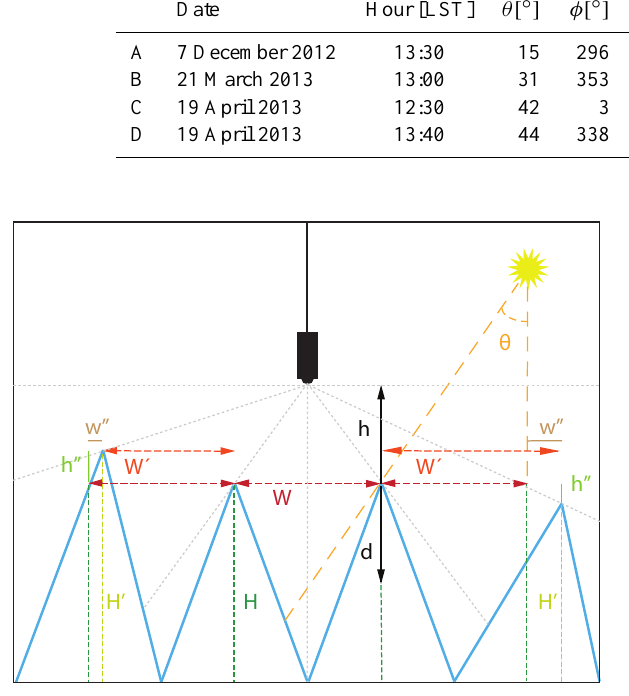
Figure 3. A conceptual 2-D view in south–north direction of an triangular shaped penitente surface with ridges and troughs in east– west orientation. It illustrates (i) the measured penitente size param- eters (height H and width W ) of the trough below the sensor, (ii) the sun geometry (solar zenith angle θ ), (iii) the location of the sensor ( h when above the tip, d when below), and (iv) the random repre- sentative neighboring penitentes in north–south direction using the size parameters H 0 = H ± h 00 and W 0 = W ± w 00